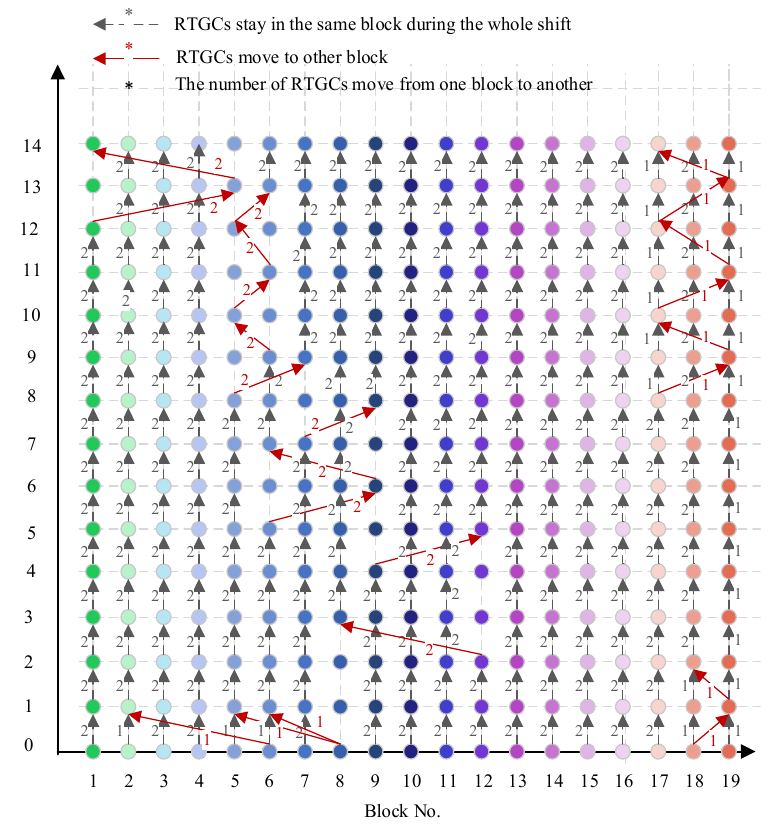
Figure 13. The RTGCs deployment plan.